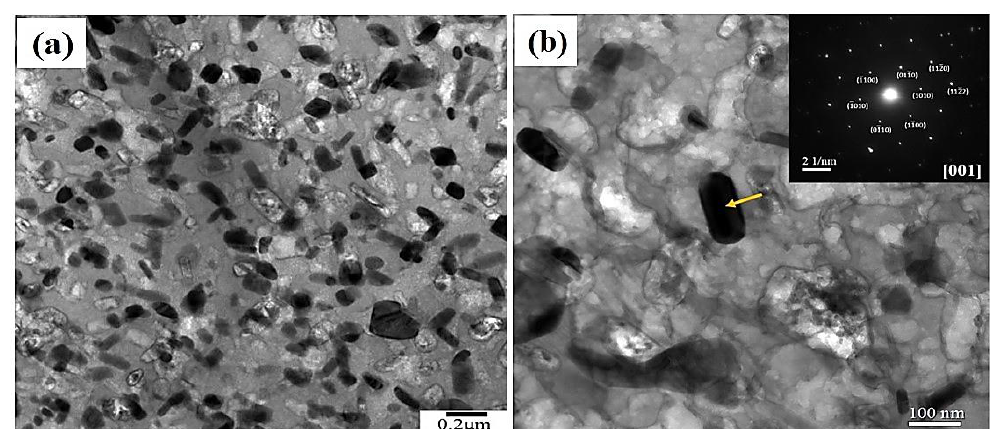
Figure 8. TEM micrographs and selected area diffraction patterns (SADP) of HTA280-12 specimen: ( a ) matrix; ( b ) [001] Al SADP.